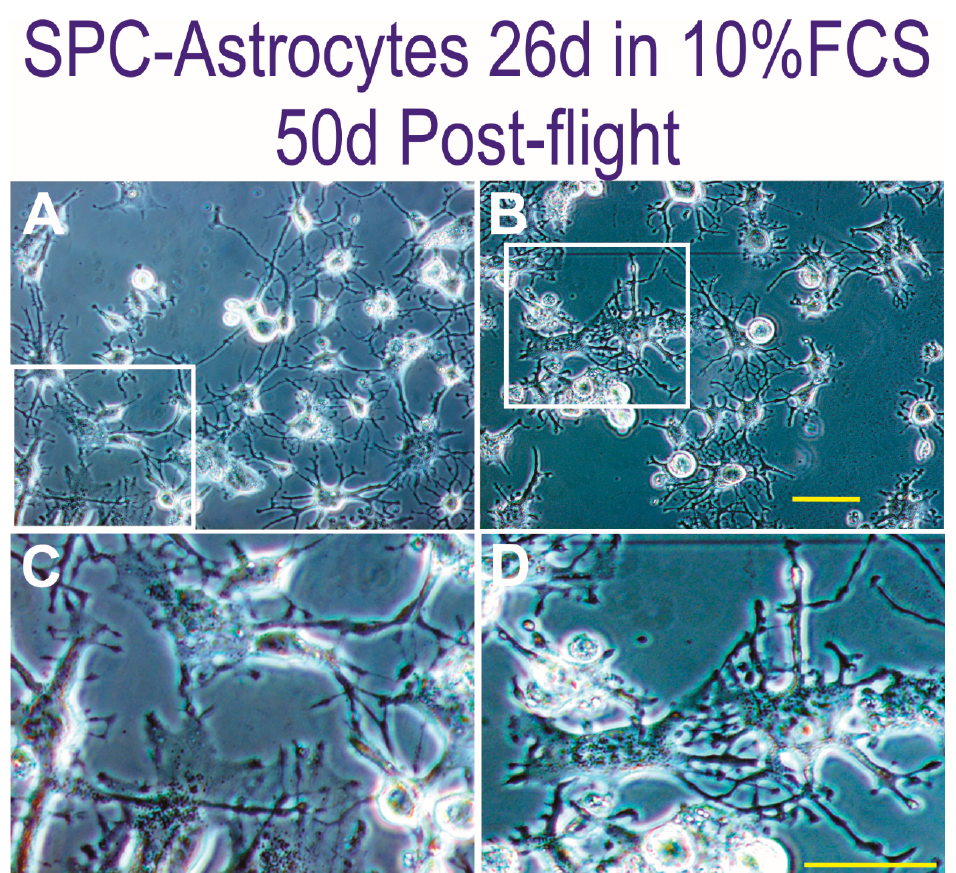
Figure 3. Induction of NSCs to the astroglial phenotype. NSCs were cultured in 10% FCS supplemented culture medium to instruct them towards the astrocyte phenotype ( A , C ). Five days after being in DF-10% medium, most cells were round and developed thin processes. At higher magnification ( C ), it was easier to see cells that had started to adopt the typical flat morphology. ( B ) and ( D ) are another example where most cells did not yet display the astrocyte morphology. View of cells at higher magnification that were becoming flat and connected with neighboring cells via their cell processes ( D ). Bars = 50 µm.